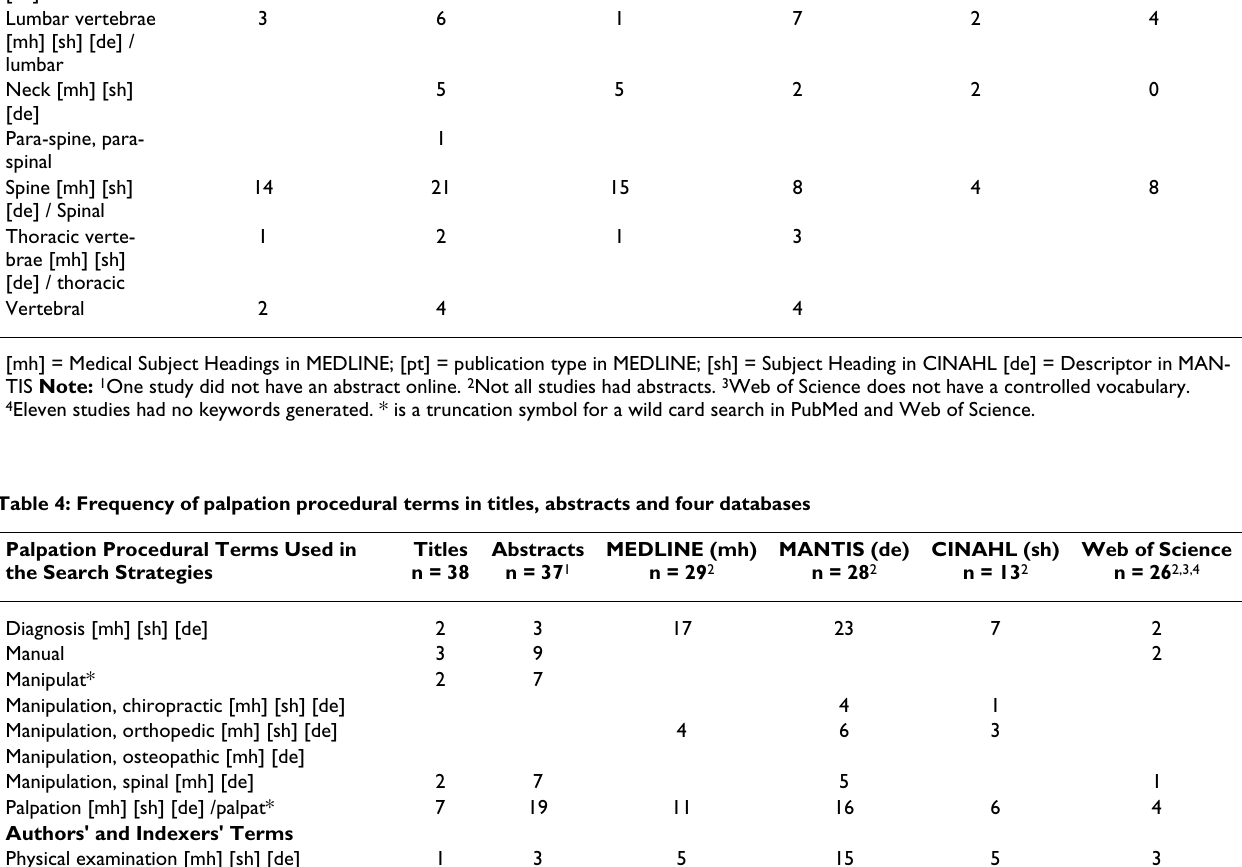
Para-spine, para- spinal